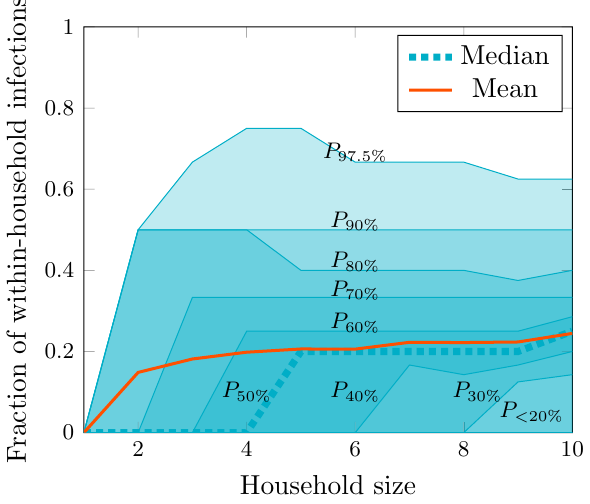
Figure 3. Fraction of within-household transmission events for households of size 1–10. Mean and percentile contours are shown for the fraction of transmission events within households. The maximal contours represent the 95% confidence interval computed as the region contained between P 2.5% (coincident with the horizontal axis) and P 97.5% .